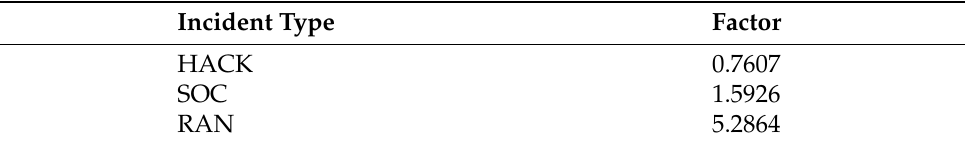
Figure 2. Under-reporting Factors as a function of Revenue. Table 1. Under-reporting Factors: Incident Type.